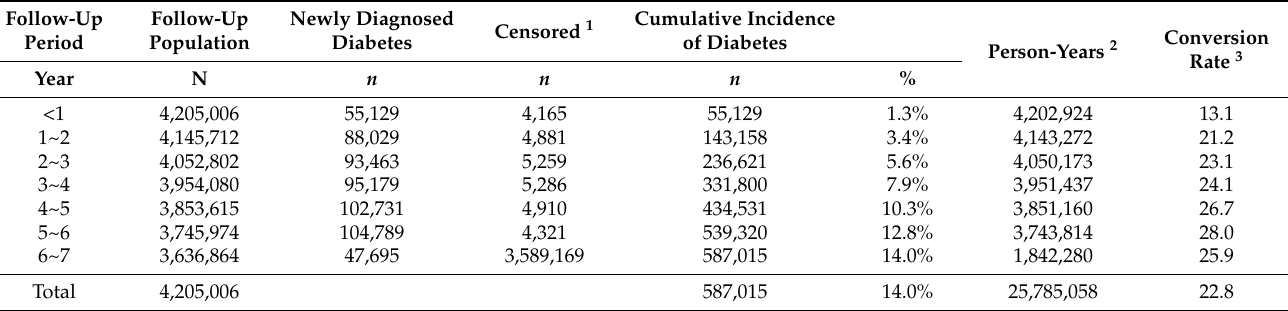
Table 2. Incidence of progression from non-diabetes to